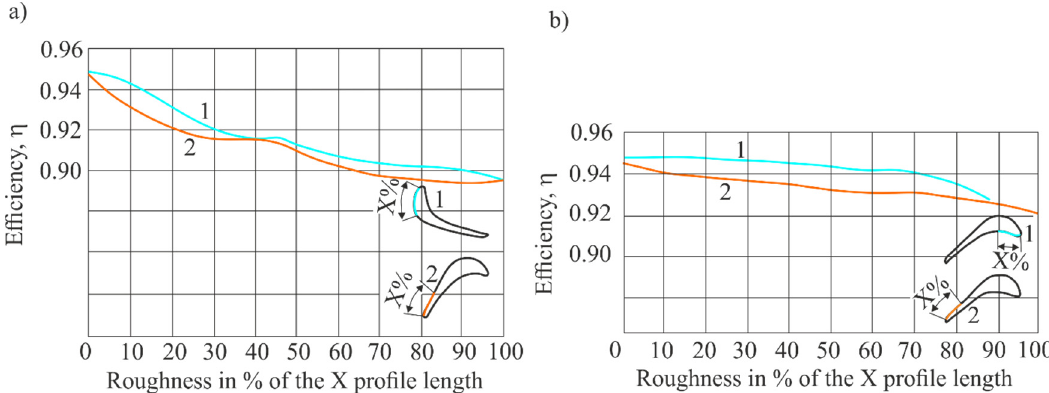
Figure 2. Effect of unevenly distributed roughness: ( a ) roughness builds up from the inlet side, ( b ) roughness builds up from the outlet side.